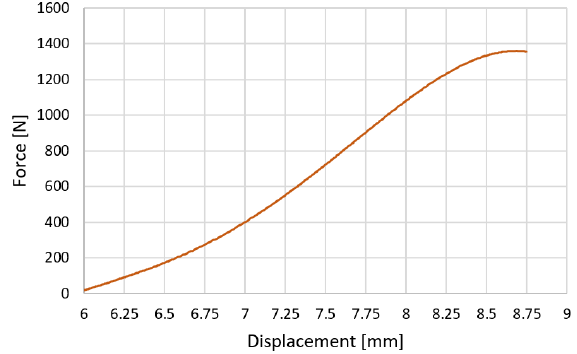
Figure 6. A sample P-D diagram of specimen n. 2 from the mechanical testing. The maximum force for this specimen was 1387.6